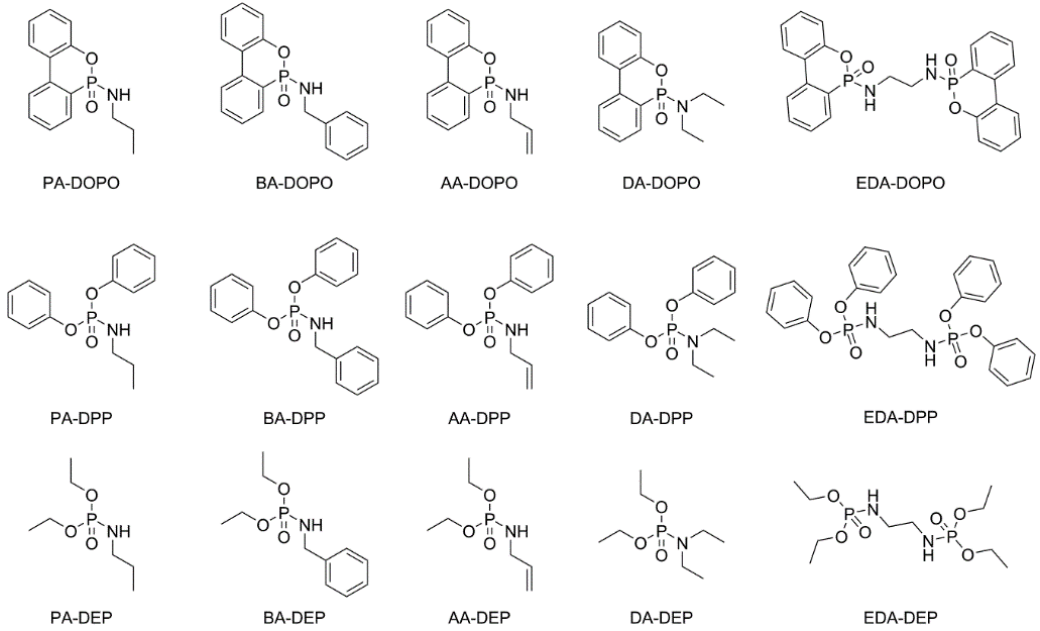
Figure 1. Chemical structures of phosphonamidates and phosphoramidates derivatives.